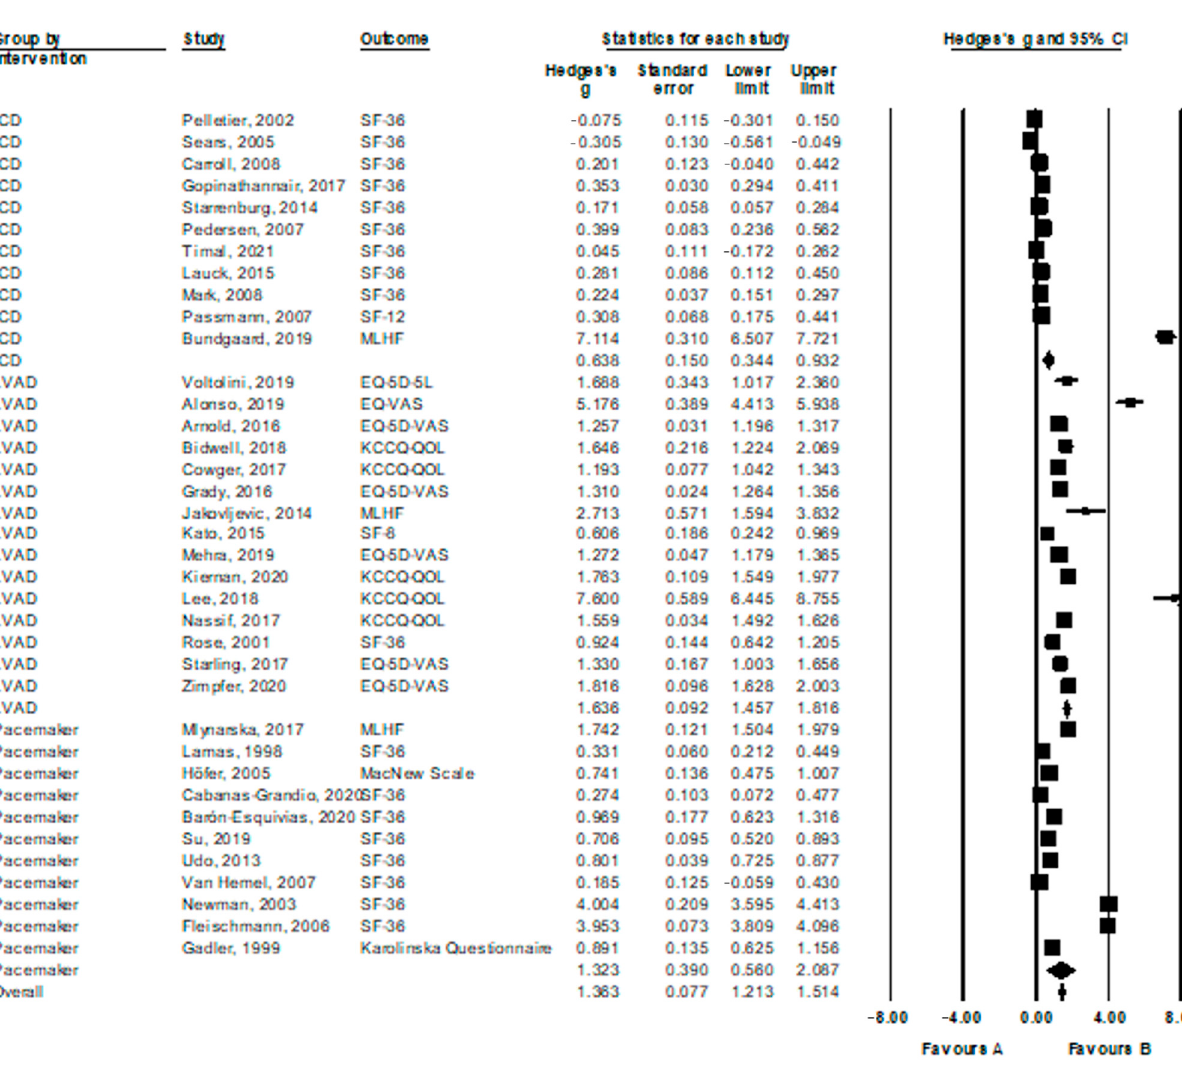
Figure 2. Forest plot of uncontrolled effect size estimates (pre- vs. 6 months follow-up) for the efficacy of device implantation on quality of life.